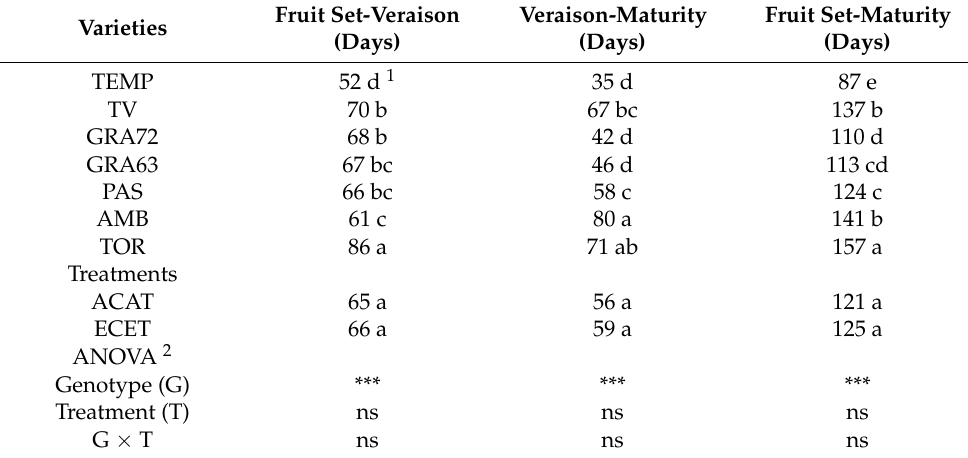
Table 1. Phenology from fruit-bearing cuttings of genotypes from seven local old grapevine varieties recovered in Navarre (Spain) grown under two climate scenarios during berry ripening: (1) ambient CO 2 (400 ppm) and ambient temperature (T) (ACAT) and (2) elevated CO 2 (700 ppm) and elevated temperature (T + 4 ◦ C) (ECET). Genotype labels can be found in Table 5.